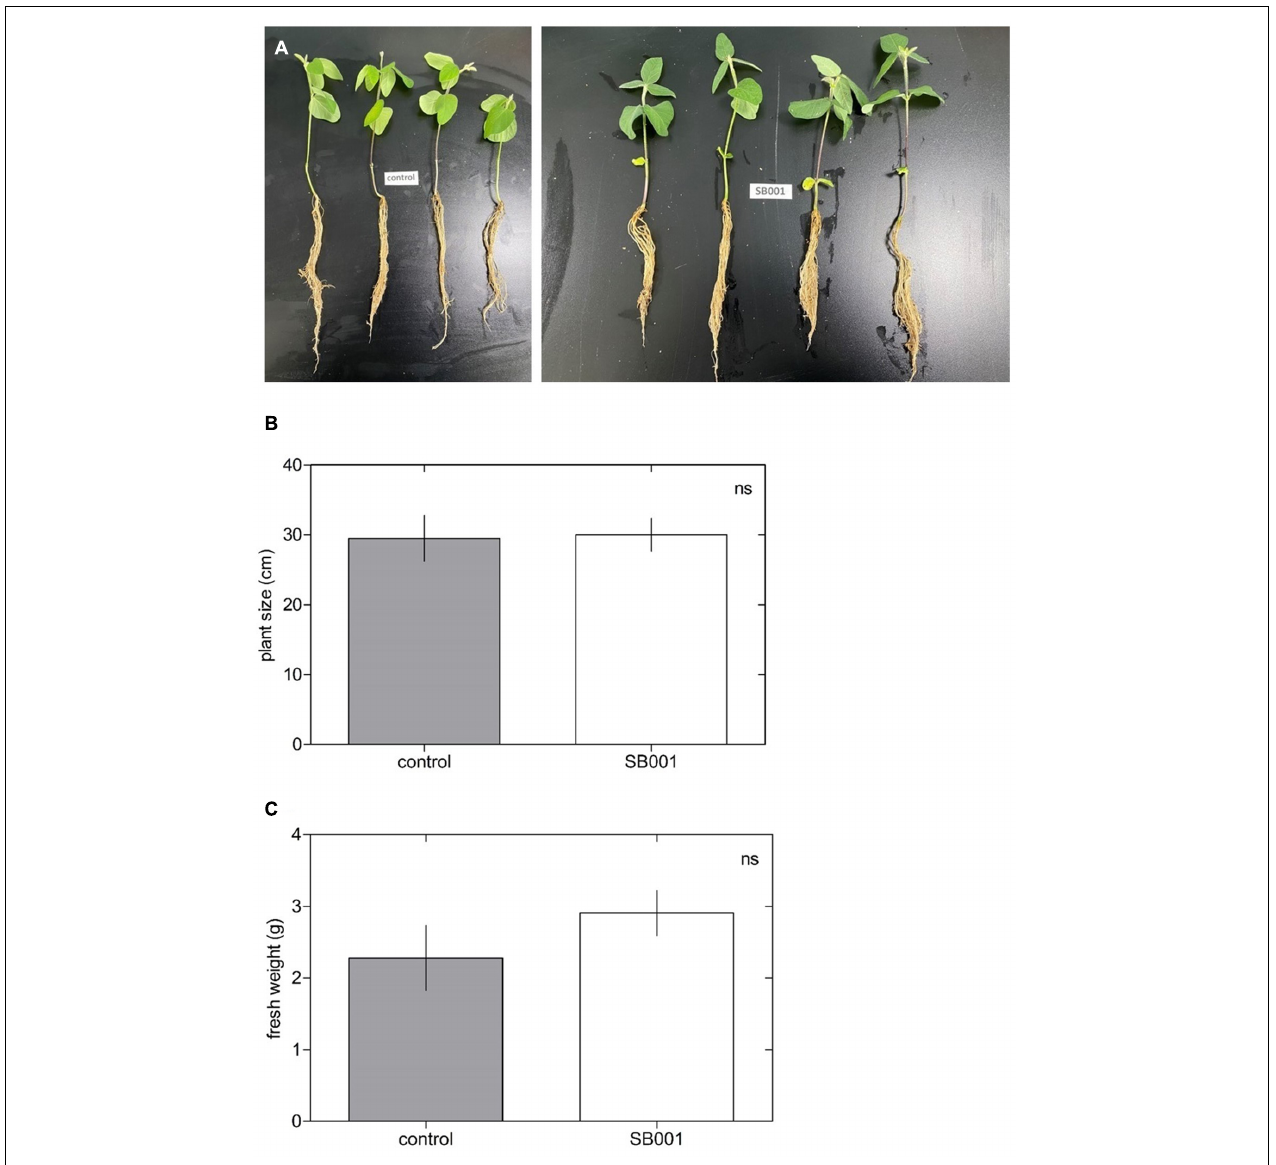
FIGURE 5 | Endophytic bacterium B. altitudinis does not induce soybean plant growth. Plants (5-day-old) were mock-treated (control) or inoculated with 30 ml of B. altitudinis at 4.77 × 10 9 CFU/ml. (A) Phenotype of soybean plants mock-treated (control) and treated with B. altitudinis fermentations (SB001) at 20 days post-inoculation. Effect on plant size (B) and fresh weight (C) of soybean plants mock-treated (control) and treated with B. altitudinis fermentations (SB001). Each bar represents mean values with standard errors of two independent experiments ( n =